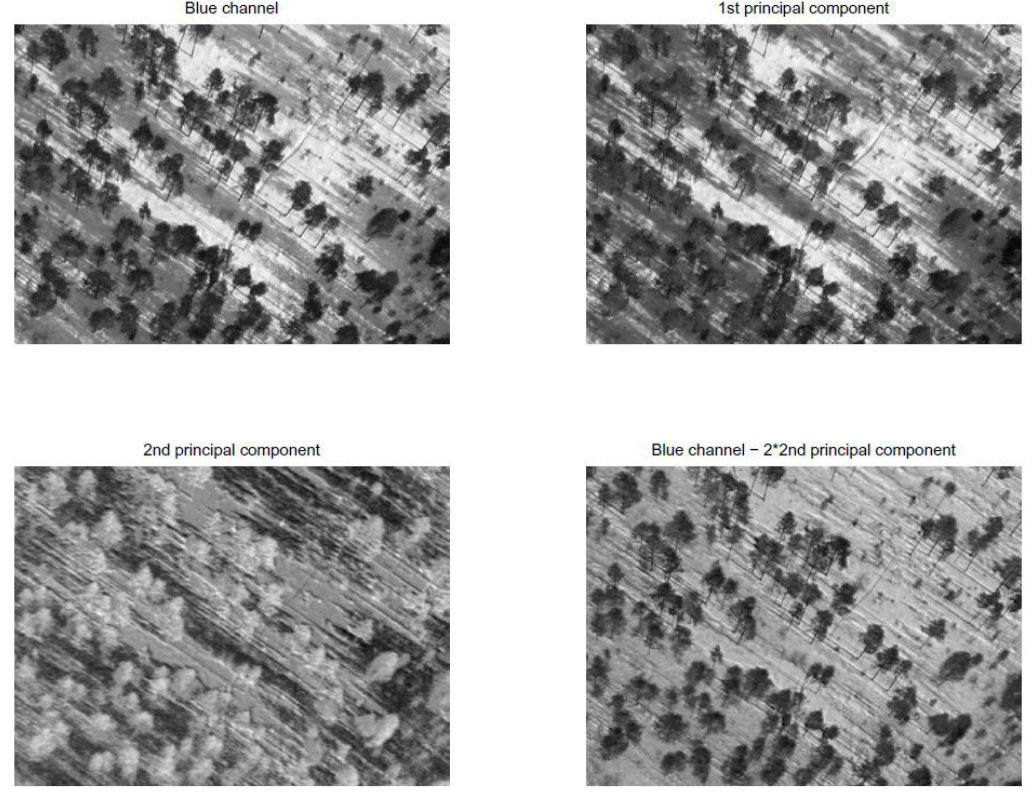
Figure 2. Use of principal components in removal of shadows from the images (just a small part of entire image is